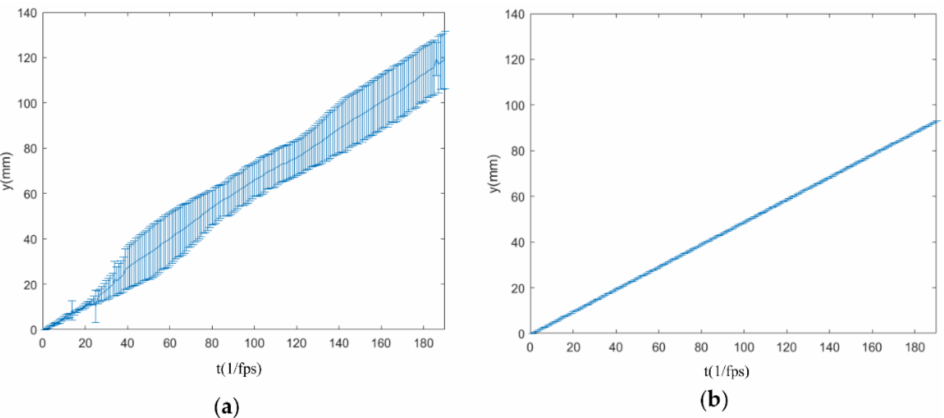
Figure 13. The y-component, rolling direction, of COM trajectory of the ball in each leg motion loop. The solid line indicates the average value of each time, and the error bar indicates the standard deviation of each time; ( a ) 40 ◦ –70 ◦ rolling range; and ( b ) 50 ◦ –80 ◦ rolling range.